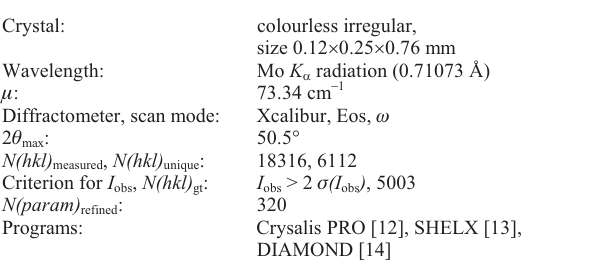
Table 1. Data collection and